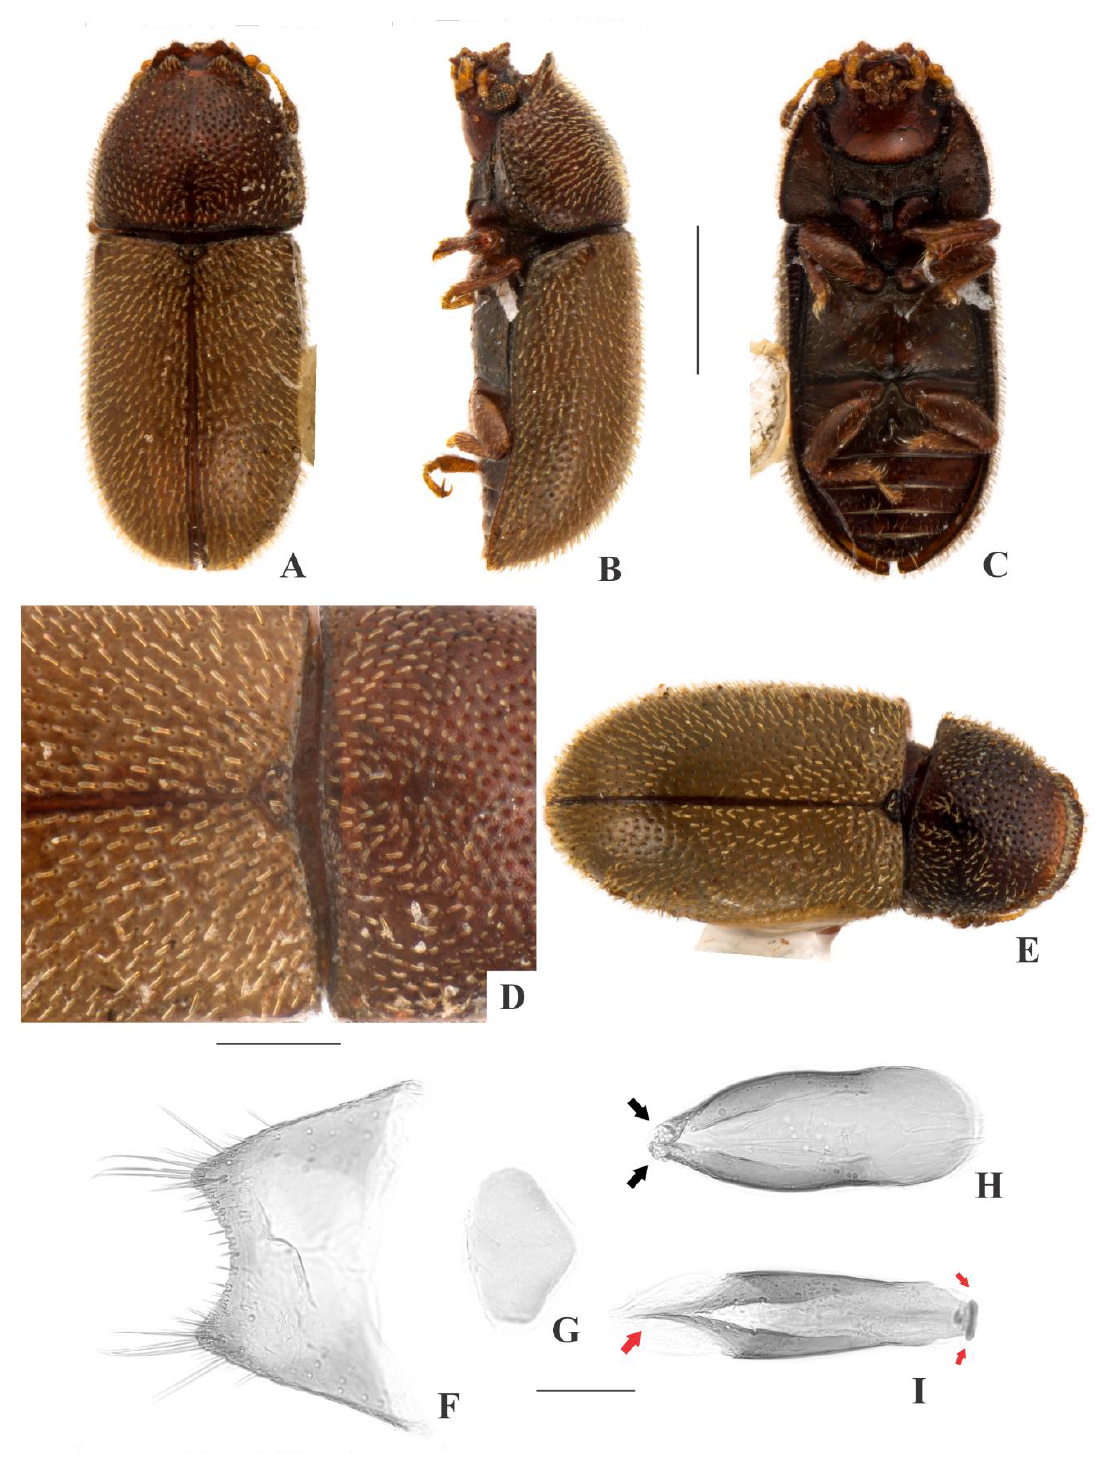
Figure 10. Cis tessariplacus sp. n. , male holotype ( A – D ), female paratype ( E ), aedeagus of holotype ( F – I ): ( A ) Dorsal view. ( B ) Lateral view. ( C ) Ventral view. ( D ) Scutellar shield and part of the pronotum and elytra. ( F ) Sternite VIII. ( G ) Basal piece. ( H ) Tegmen, note globular tubercles at apical portion (black arrows). ( I ) Penis, note acute sclerotization at middle of apical portion (big red arrow) and truncate sclerotization at anterior portion (small red arrows). Scale bars: 0.5 mm ( A – C , E ), 0.2 mm ( D ), 0.05 mm ( F – I ). Cis sp. L in Neser